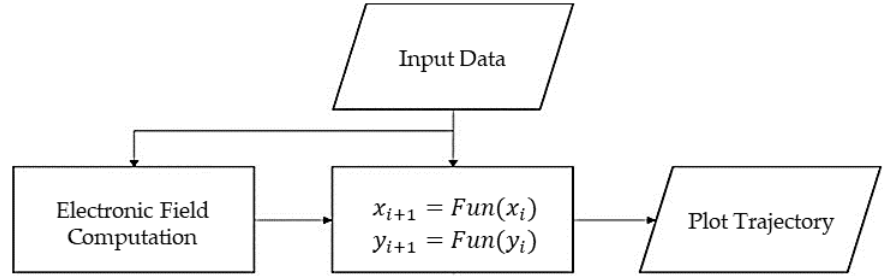
Figure 4. Flowchart of the particle trajectory analysis method.